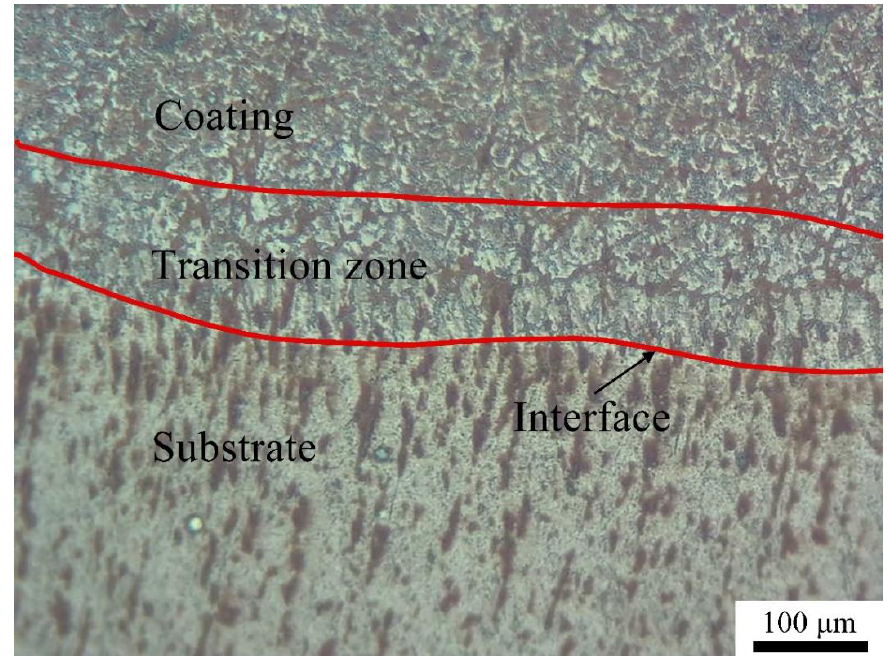
Figure 4. The morphology of the interface in the CoCrFeNiAl coating.